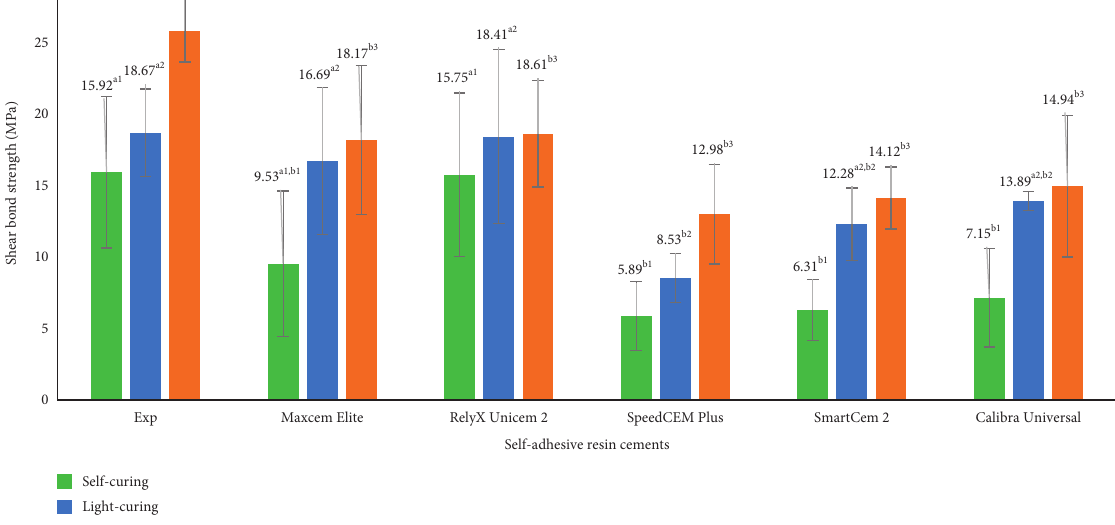
Figure 2: Shear bond strength to dentin of self-adhesive resin cements (values with the same superscript are statistically equivalent between the tested